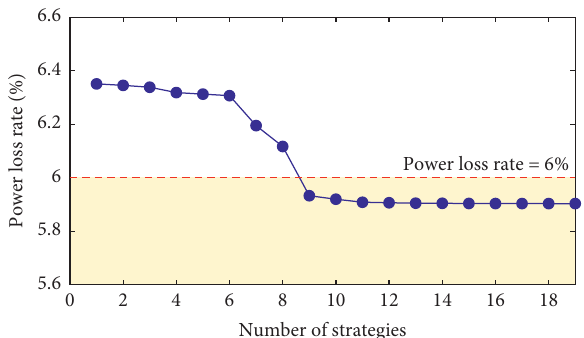
Figure 11: The result of the power loss rate after a combination of multiple